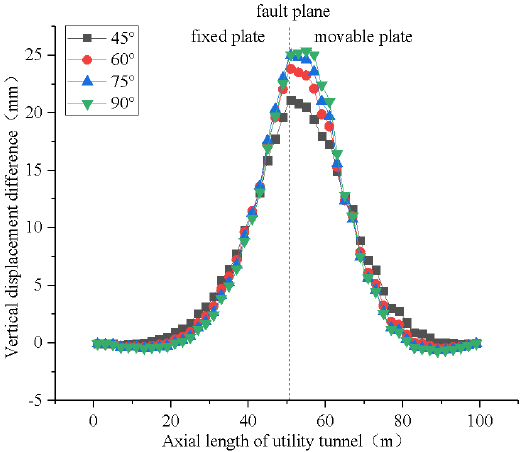
Figure 17. Vertical displacement distribution curve.